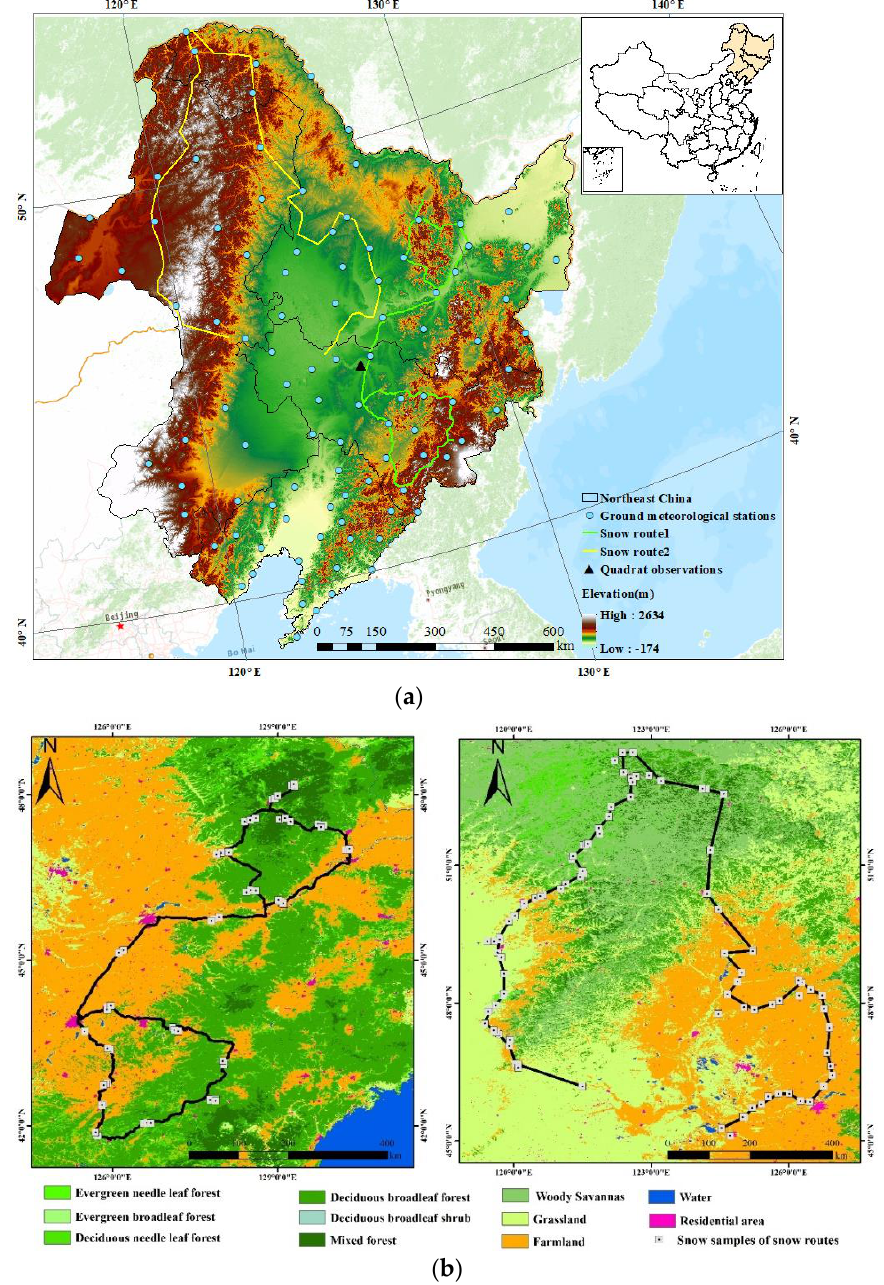
Figure 1. The study area is located in Northeast China. ( a ) The base map shows the elevation and spatial distribution of ground meteorological stations, the two colored lines are the field snow survey routes, and the black triangles represent snow observations within the quadrat. ( b ) Distributions of SD samples along two snow routes, respectively.